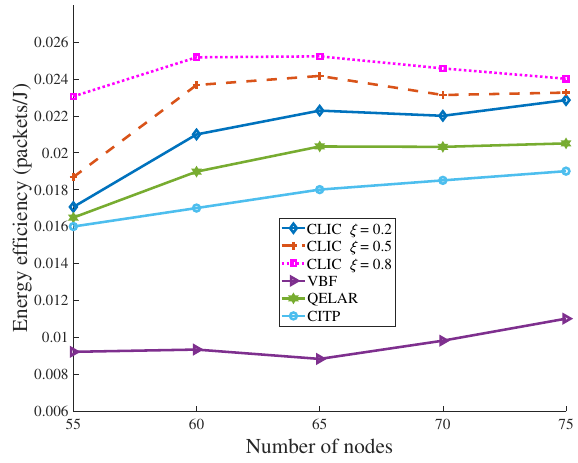
Figure 11. Comparison of energy consumption versus the number of nodes.